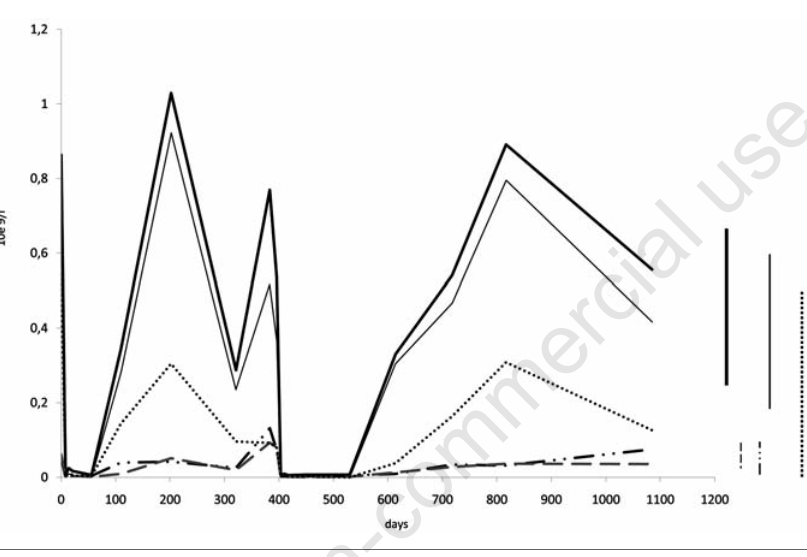
Figure 2. B-lymphocyte subpopulations. Timeline starts in August 2005, directly after first rituximab treatment, shows depletion after 2 nd rituximab treatment and continues until roughly 2.5 years remission. Total B-lymphocytes (CD19 + ) bold line; naive B-lym- phocytes (CD19 + IgD + CD27 - ) narrow line. Switched memory B-lymphocytes (CD19 + IgD - CD27 + )